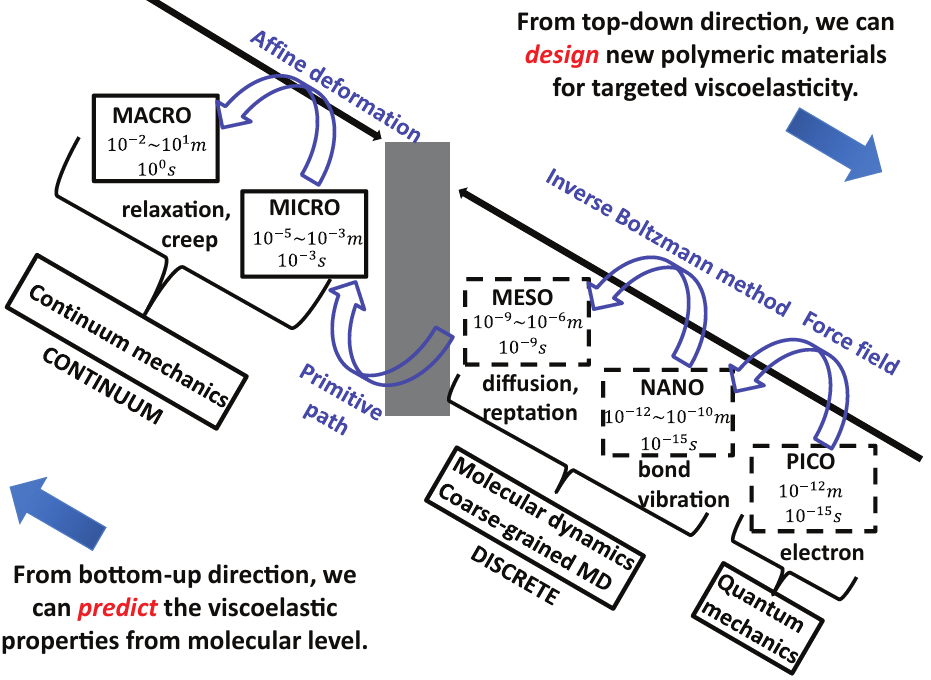
Hierarchical multiscale computational framework adopted to predict the viscoelastic properties of polymers. Different time and length scales are connected through different bridging laws. Figure reproduced with permission from [92].